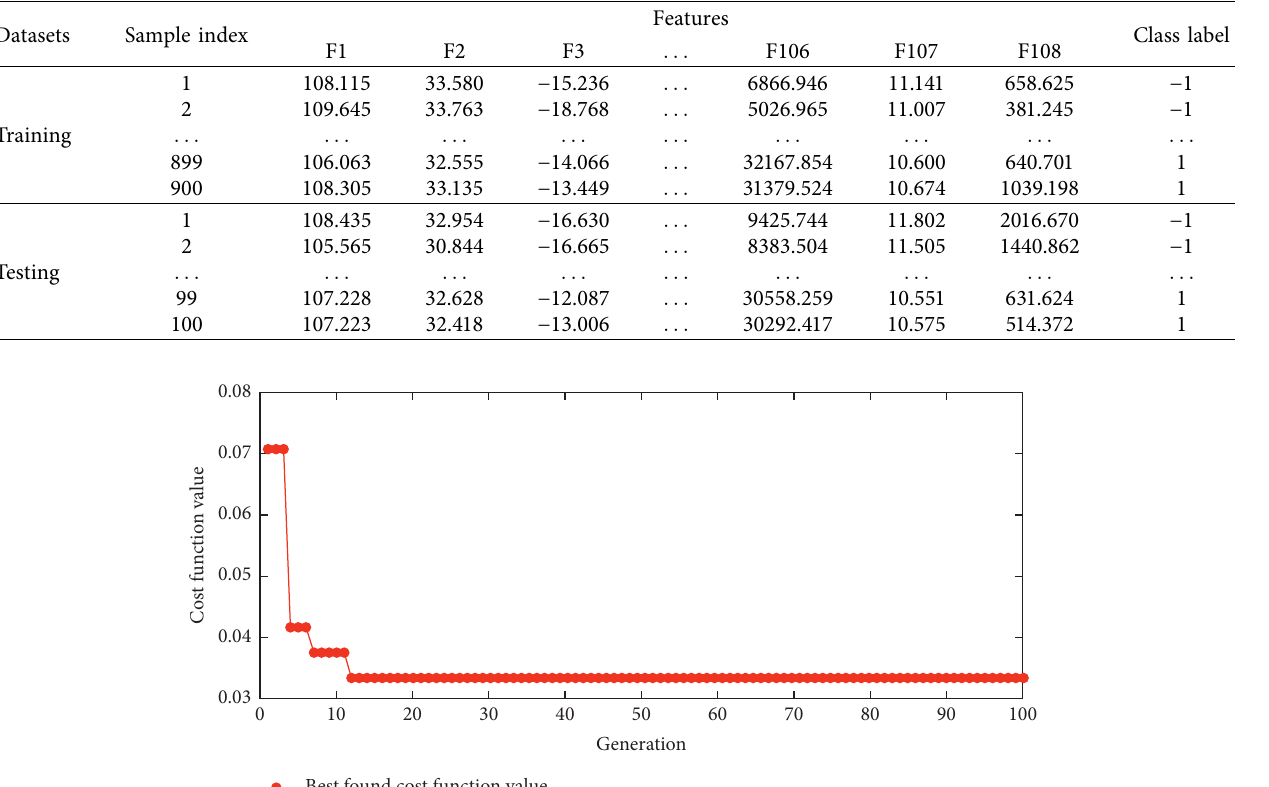
Table 1: The training and testing datasets.